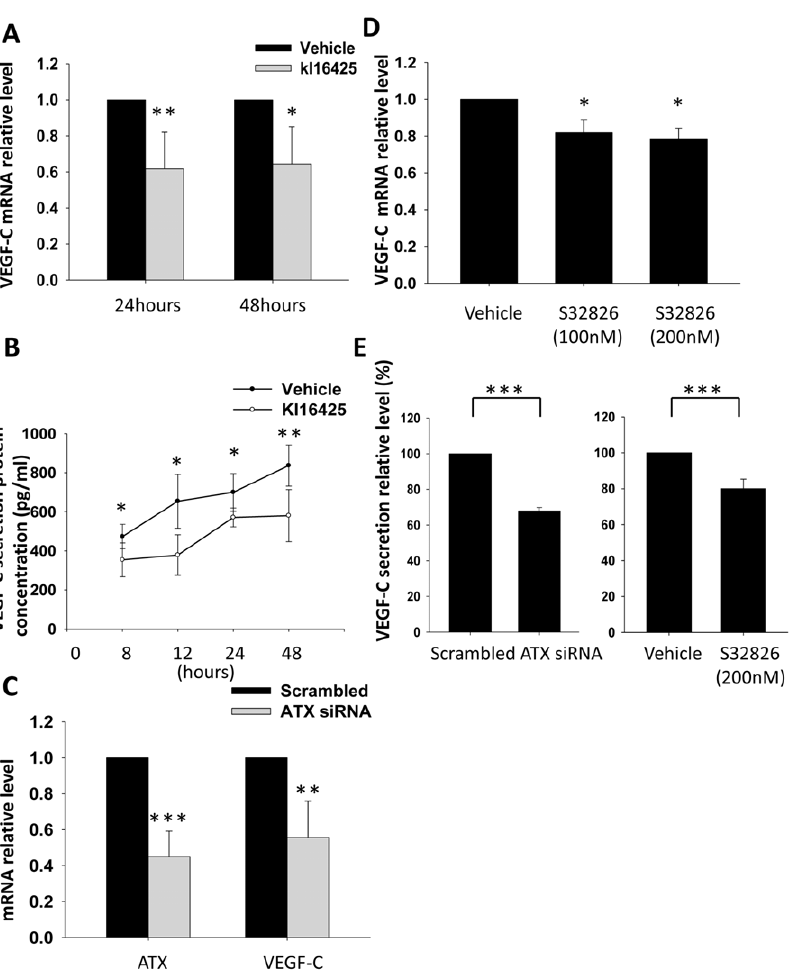
Figure 5. The role of ATX in regulating VEGF-C expression in PC-3 cells. After 16 h of starvation, PC-3 cells were treated with 10 m M Ki16425 in RPMI1640 with 0.005% fatty acid BSA for 8, 12, 24, and 48 h. The relative level (A) and secretion concentration of VEGF-C mRNA (B) in samples were determined. Furthermore, PC-3 cells were transfected with ATX siRNA for 24 h to knock down the ATX gene. PC-3 cells were cultured in RPMI-1640 with 0.005% fatty acid free BSA for another 24 h, and sample RNA was collected. In addition, the inhibitor, S32826, was also used to inactivate ATX activity for 12 h. ATX and VEGF-C mRNA expressions (C and D) were measured. Following the same protocol, PC-3 cells transfected with ATX siRNA and treated with S32826 were starved and cultured in RPMI-1640 with 0.005% fatty acid free BSA for 48 h. VEGF-C secretion concentrations (E) of samples were determined. Sample mRNA was reverse-transcribed and analyzed by a real-time PCR. Relative levels of genes normalized to b -actin are shown. VEGF-C secretion concentrations were measured by an ELISA. * Statistically different compared to the vehicle-incubated sample treated and transfected with Ki16425 and ATX siRNA (* p , 0.05; ** p , 0.01; *** p , 0.001).